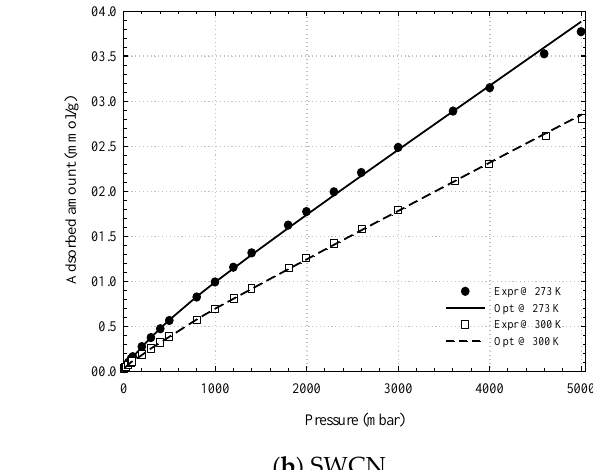
Figure 12. Snapshots of CO 2 in 6.3, 9 and 20 Å pores at 273 K.